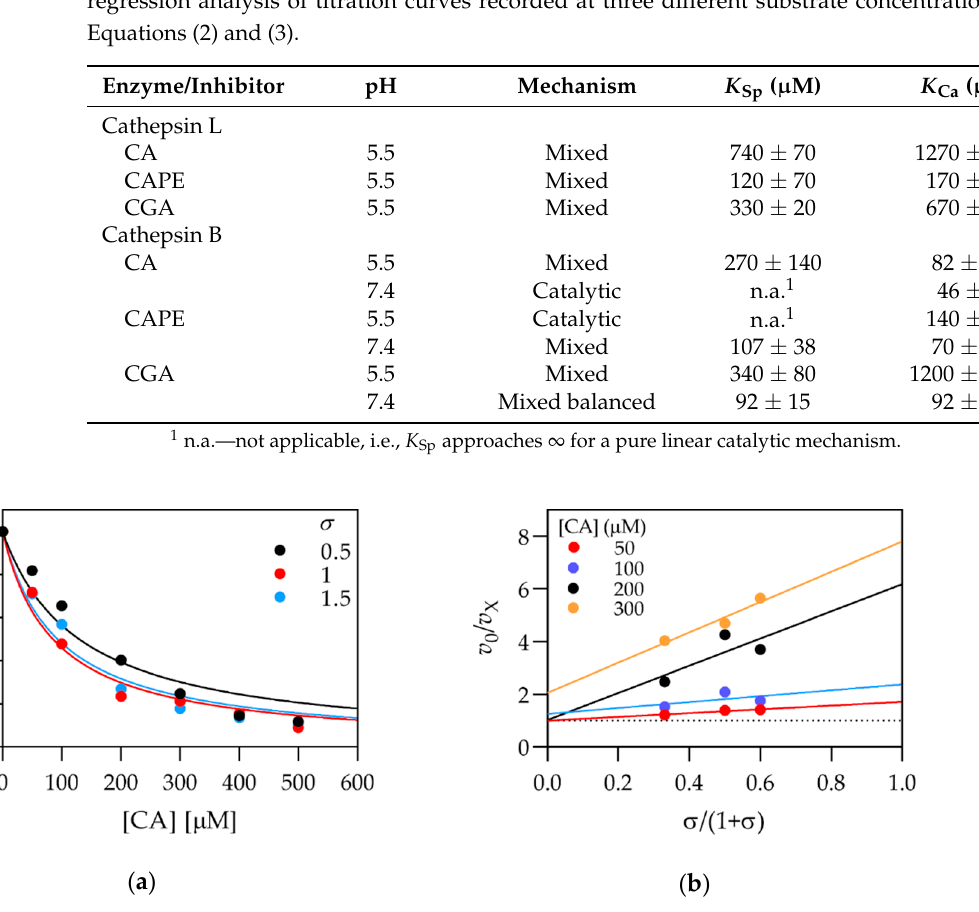
Figure 3. Kinetic characterization of the inhibition of cathepsin B by CA at pH 7.4: ( a ) Titration curves produced at three different substrate concentrations. Increasing inhibitor efficiency with increasing substrate concentration indicates predominantly catalytic inhibition; ( b ) replot of the data in panel ( a ) in the form of the specific velocity plot. Straight lines (corresponding to individual inhibitor concentrations) intersect the y = 1 axis at x values near 0, indicating a pure catalytic mechanism. σ equals [S]/ K m . Experiments were performed at 25 °C in 20 mM Na-phosphate buffer pH 7.4 with 1 mM EDTA and 2.5 mM